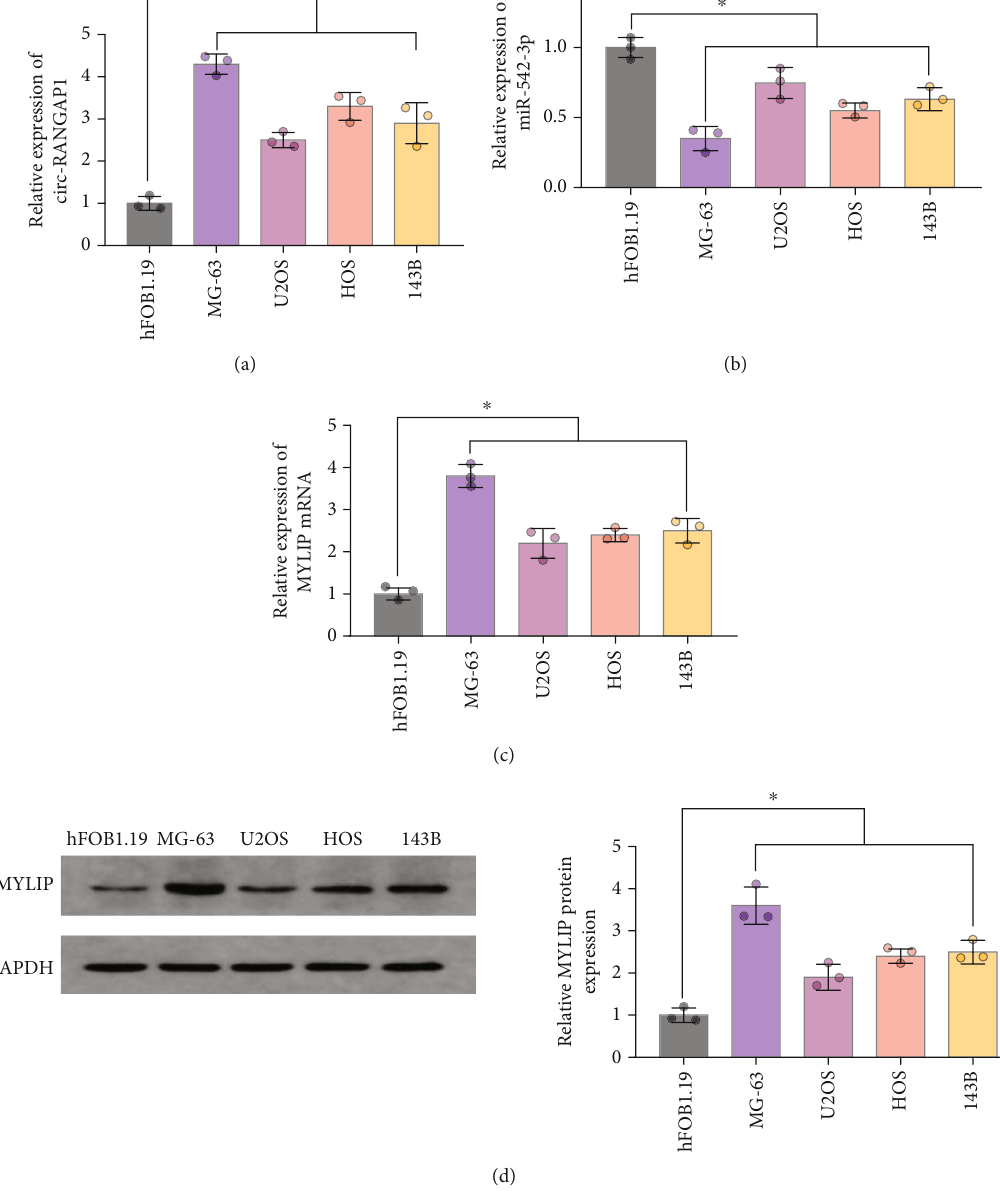
Figure 2: circ-RANGAP1, MYLIP, and miR-542-3p in each cell. (a) circ-RANGAP1 in each cell. (b) miR-542-3p in all cell. (c) MYLIP in all cells. (d) MYLIP protein in all cells. The data in the fi gure were all measurement data in the form of mean ± SD . ∗ P < 0 : 05 versus the